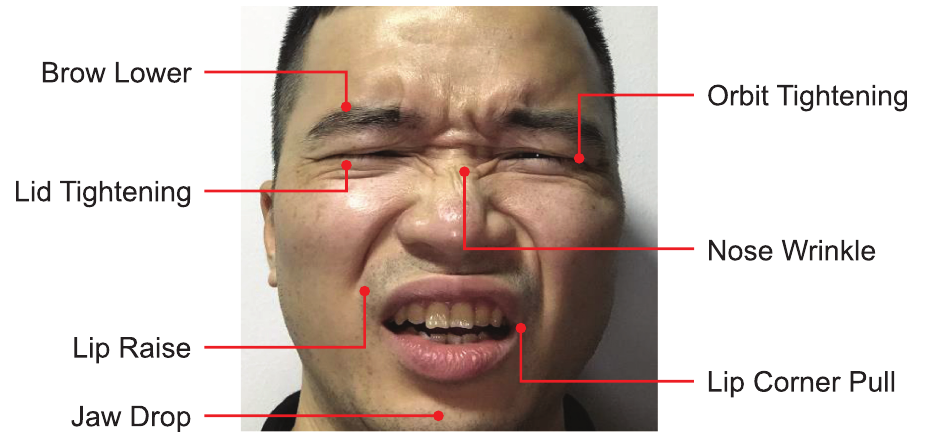
Fig 1. Facial action coding of seven component actions when pain occurs. It is noted that the picture was collected by the author himself and agreed to be published in Plos One.